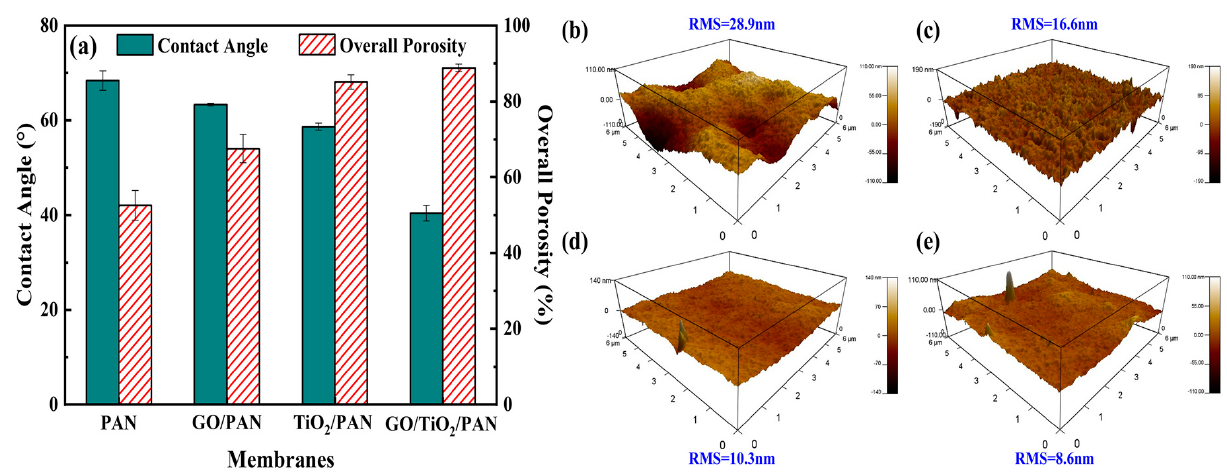
Figure 9. ( a ) contact angle and overall porosity of the PAN, GO/PAN, TiO 2 /PAN, and GO/TiO 2 /PAN MMMs, 3D AFM images and mean roughness of the ( b ) PAN, ( c ) GO/PAN, ( d ) TiO 2 /PAN, and ( e ) GO/TiO 2 /PAN MMMs top surface.